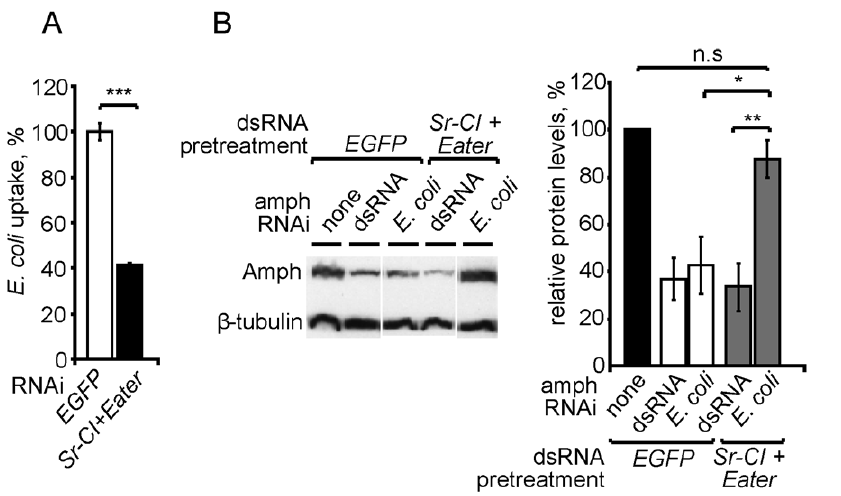
Figure 4. Dependence of E.coli -mediated RNAi on Sr-CI and Eater. ( A ) Inhibition of phagocytosis of E. coli after RNAi treatment for either EGFP (control) or Sr-CI and Eater. ( B ) Inhibition of phagocytosis impairs RNAi mediated by dsRNA-expressing E. coli but not by naked dsRNA. Western blot for Amph and b -tubulin from cultures of S2 cells pretreated with RNAi for either EGFP (control) or Sr-CI and Eater, and subsequently treated with either naked amph dsRNA or E. coli that express amph dsRNA. Bar graph shows levels of amphiphysin protein relative to b -tubulin. In all panels, error bars indicate standard error of the mean. * P , 0.05; ** P , 0.01; *** P , 0.005; n.s. P . 0.05; two-tailed t-test. All quantitative data are based on at least three independent